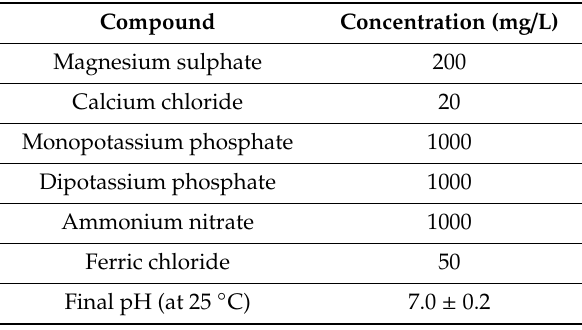
Table 2. Comparison of Bushnell Haas